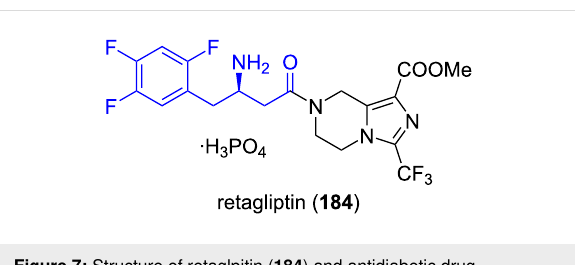
Figure 7: Structure of retaglpitin ( 184 ) and antidiabetic drug.